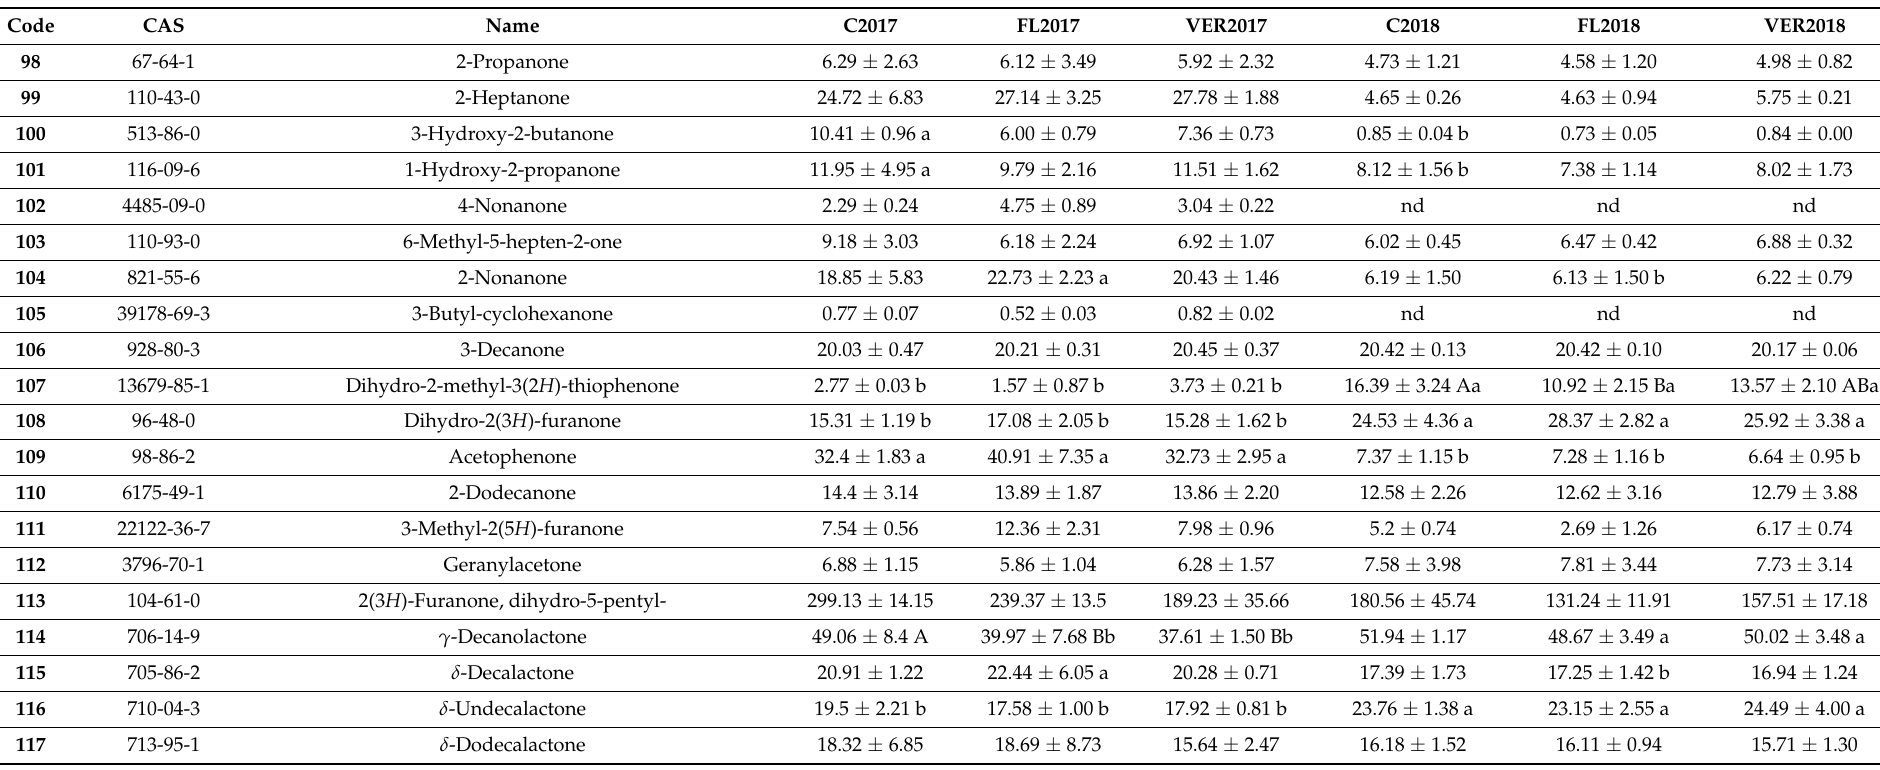
Table 6. Effects of defoliation treatments and vintage on concentrations of ketones ( µ g/L). (The quantification was conducted by using β -damascenone.) C = control; FL = removal of six leaves before flowering; VER = removal of six leaves at the end of